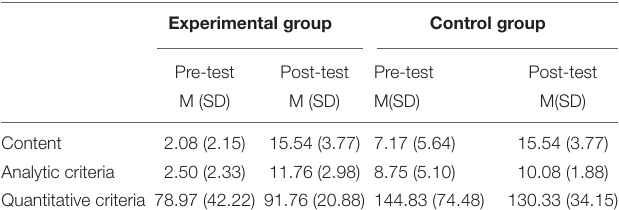
TABLE 3 | Means (M), Standard Deviations (SD) of the story writing of the english text criteria for the average and above average students. Experimental group Control